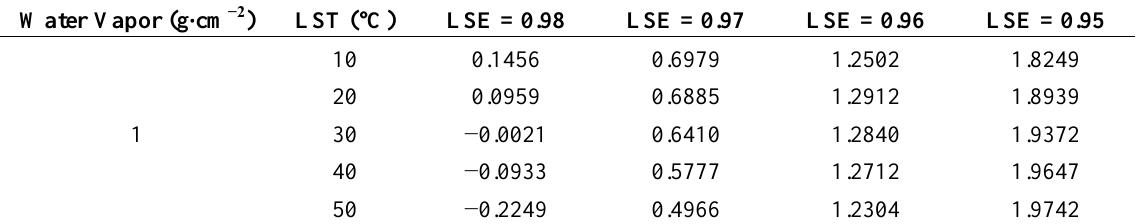
Table 3. Estimation errors of Land Surface Temperature (LST) for various simulated combinations of LST, Land Surface Emissivity (LSE), and atmospheric water vapor